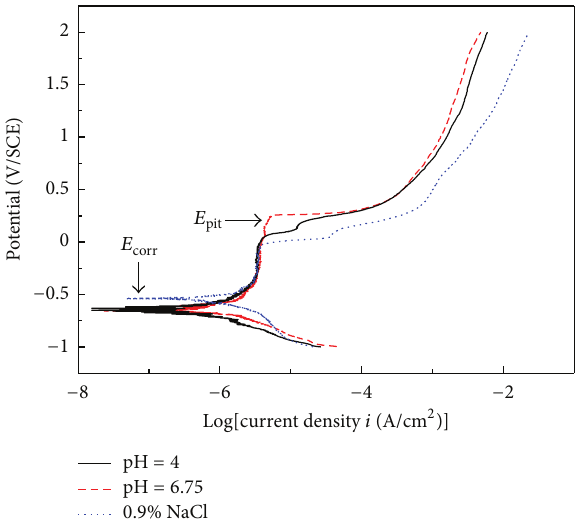
Figure 4: Representative cyclic polarization curves of composite arch wires in different